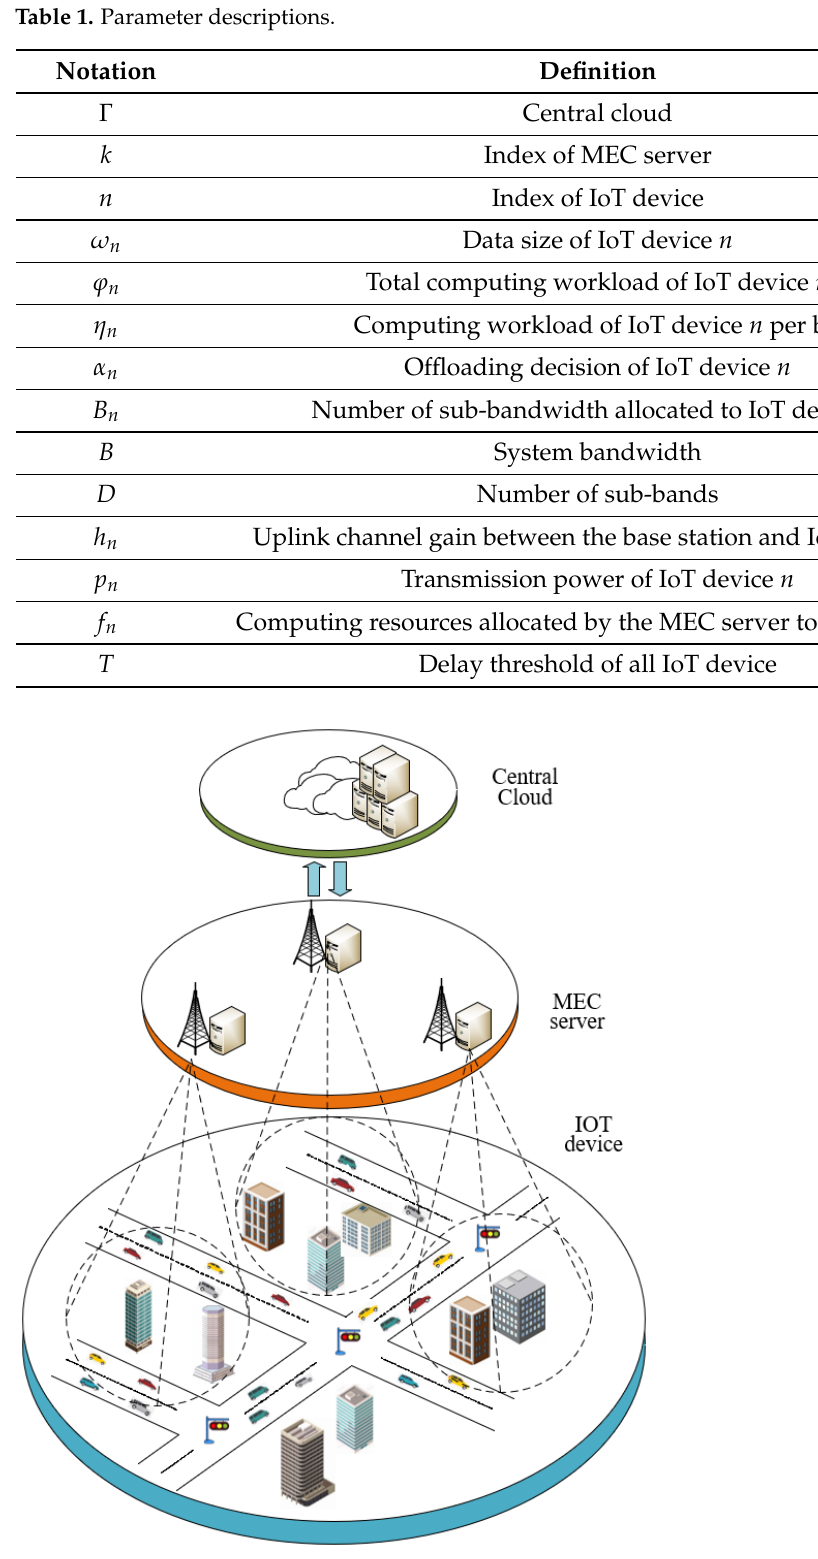
Figure 1. System